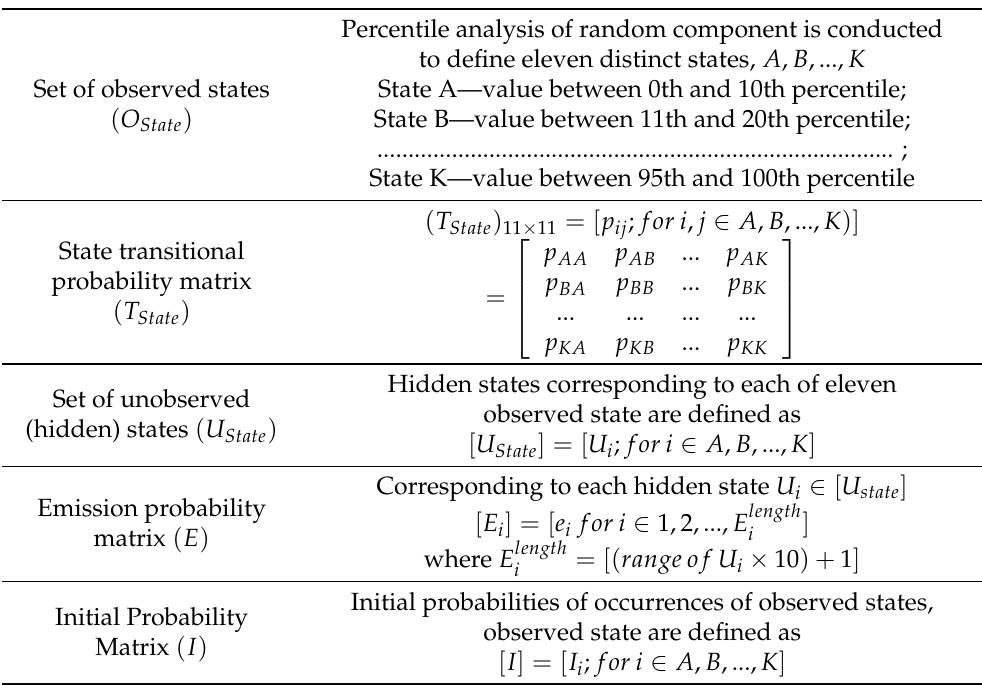
Set of observed